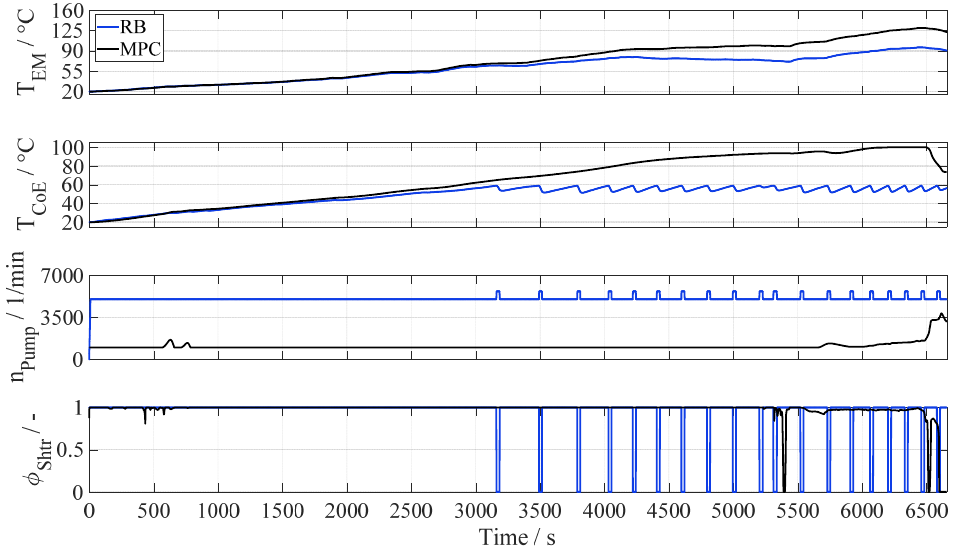
Figure 9. Comparison of MPC and rule-based strategy (RB) regarding motor temperature (cid:1846) (cid:3006)(cid:3014) , mo- outlet coolant temperature T CoE , pump speed n Pump , and shutter position φ Shtr for the Eifel Cycle at tor outlet coolant temperature (cid:1846) (cid:3004)(cid:3042)(cid:3006) , pump speed (cid:1866) (cid:3017)(cid:3048)(cid:3040)(cid:3043) , and shutter position (cid:2038) (cid:3020)(cid:3035)(cid:3047)(cid:3045) for the Eifel 20 ◦ C initial component temperature and 20 ◦ C ambient Cycle at 20 °C initial component temperature and 20 °C ambient temperature.